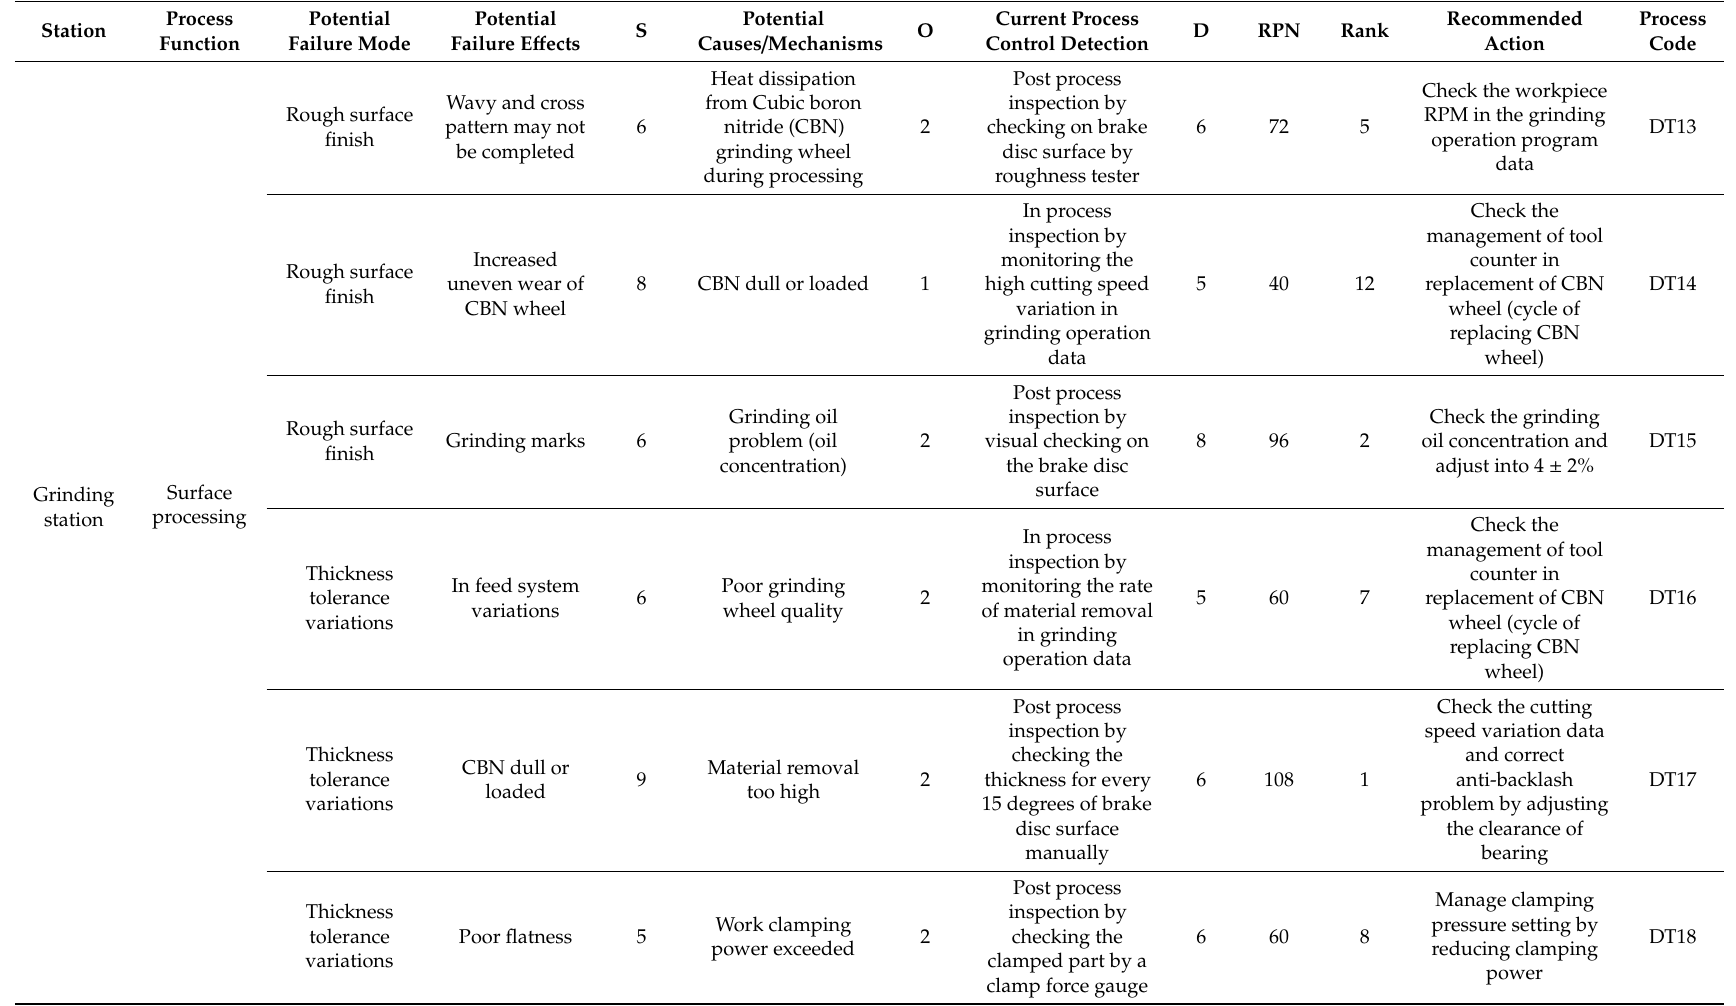
Table 1. FMEA datasheet of disc thickness variation